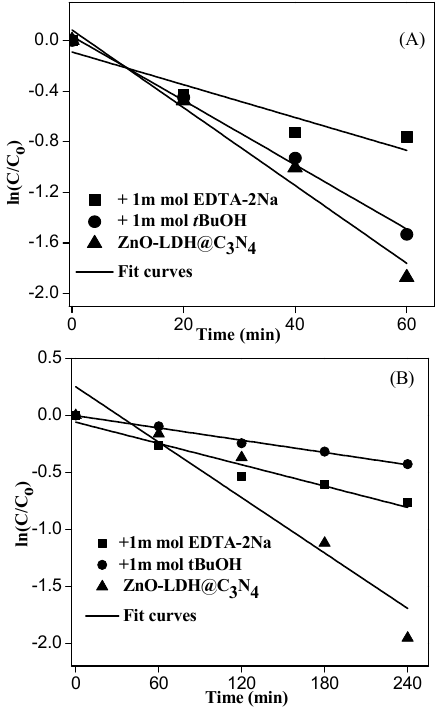
Figure 6. ( A ) The experimental data and the fitting plots of photogenerated carriers trapping in the photodegradation of MB by ZnO-LDH@C 3 N 4 under UV-light irradiation; ( B ) The experimental data and the fitting plots of photogenerated carriers trapping in the photodegradation of MB by ZnO-LDH@C 3 N 4 under visible-light irradiation.